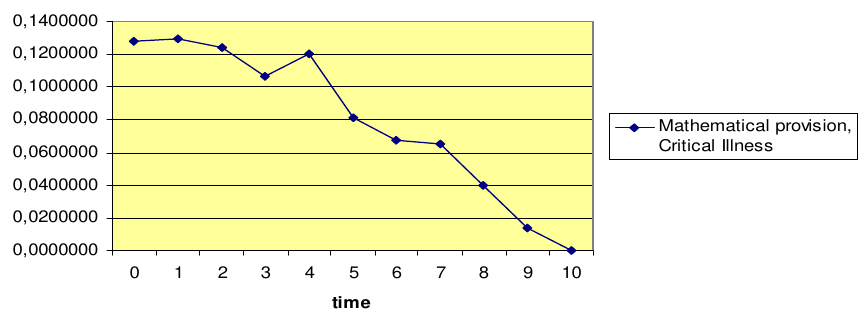
Fig. 10. Mathematical provision critical illness cover, 10 years – Poisson LC